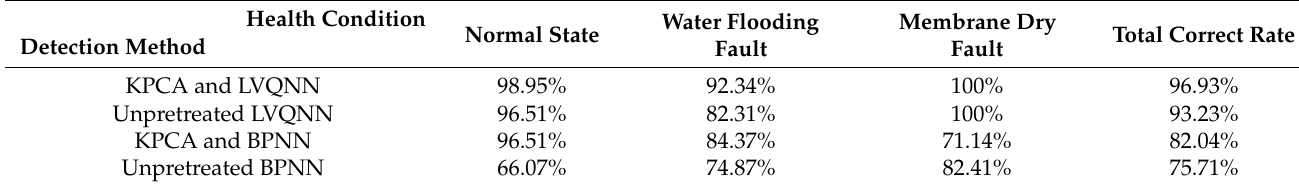
Table 4. Health status recognition accuracy of test sets with different detection methods.